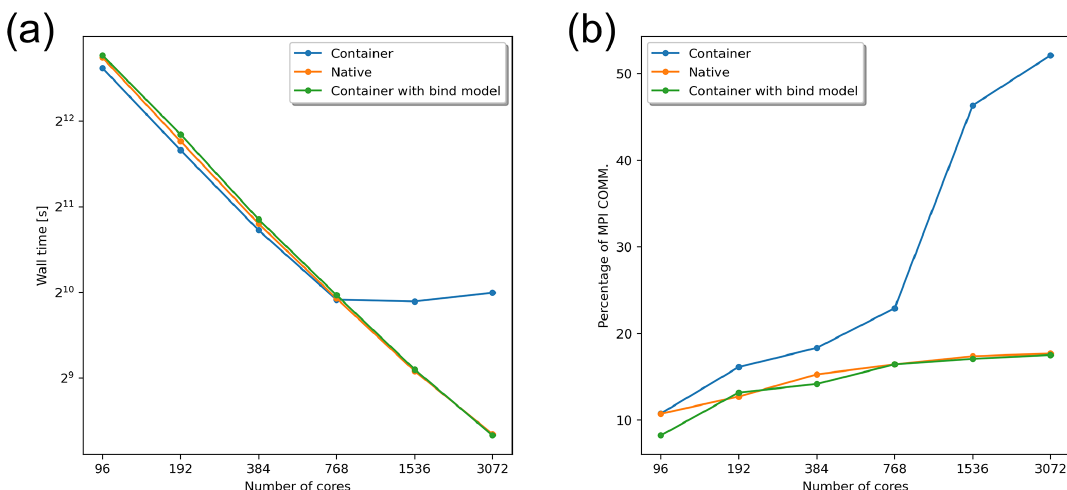
Figure 5. (a) Performance and scalability of the containerized SHiELD, the native SHiELD, and the containerized SHiELD built with the bind model. (b) Ratio of the MPI communication to the total computational cost in the case of the containerized SHiELD, the native SHiELD, and the containerized SHiELD with the bind model. Results are from 12h global simulations at a resolution of ∼ 13km. For both containers, Singularity is